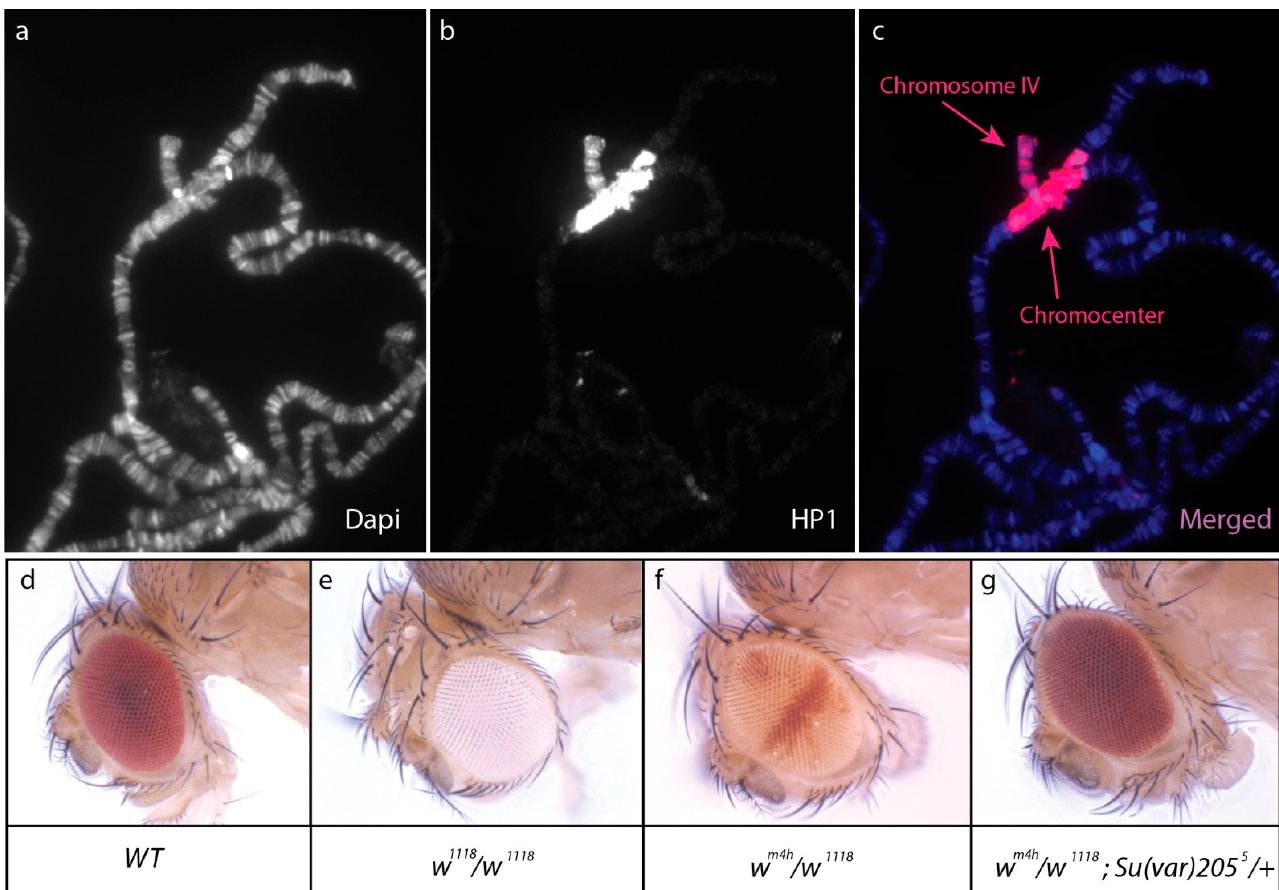
Figure 1. Heterochromatin represses neighboring genes. ( a – c ): HP1a immunostaining of salivary gland polytene chromo- somes reveals the heterochromatic nature of chromosome IV and the chromocenter. DNA is stained with DAPI (in blue). ( d – g ): Position effect variegation of white ( w ) and the effect of a mutation in Su(var)205 . Wild-type flies have red eyes ( d ), whereas flies carrying a loss of function mutation of w ( w 1118 ) have white eyes ( e ). The w m 4 h inversion relocates w close to the pericentromeric heterochromatin; silencing of w by the stochastic spreading of heterochromatin leads to a mosaic phe- notype ( f ). Mutation in Su(var)205 encoding HP1a dominantly suppresses this variegation ( g ).